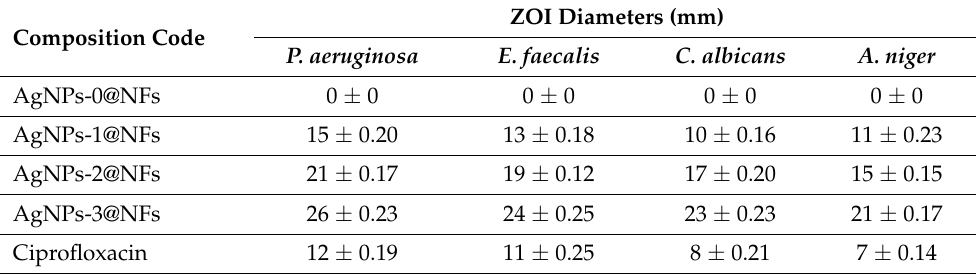
Table 2. The antimicrobial activity and ZOI diameters for AgNPs-0@NFs, AgNPs-1@NFs,